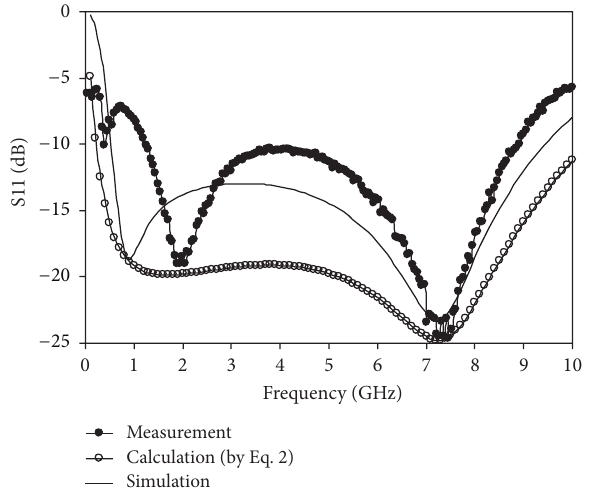
Figure 6: Conversion gain of the proposed receiver